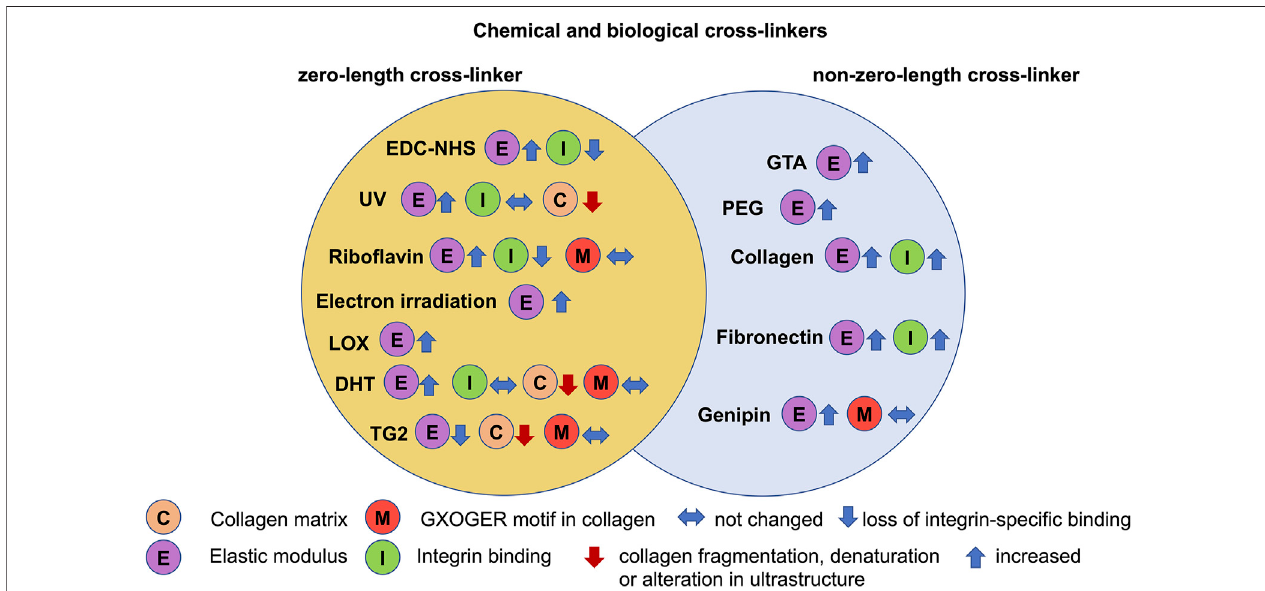
FIGURE 4 | Chemical and biological cross-linkers serve as modi fi ers for 3D collagen matrices. Among them are zero-length (yellow circle), including 1-ethyl-3-(3- dimethylamino propyl) carbodiimide hydrochloride (EDC)-N-hydroxysuccinimide (NHS), ultraviolet radiation (UV), ribo fl avin, electron irradiation, dehydrothermal treatment (DHT), lysyl oxidase (LOX) and transglutaminase 2 (TG2) and non-zero-length cross-linkers (blue circle), such as glutaraldehyde (GTA), polyethyleneglycol (PEG), collagen, fi bronectin and genipin.